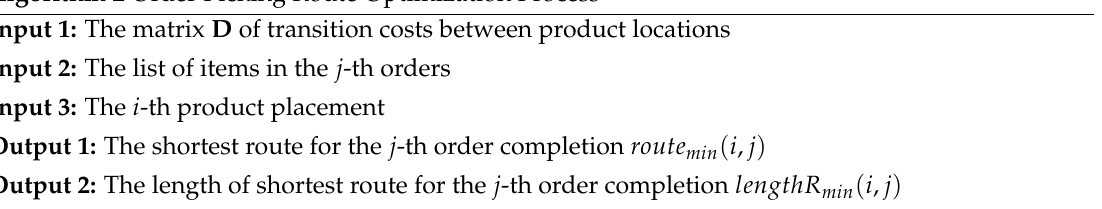
Algorithm 2 Order Picking Route Optimization